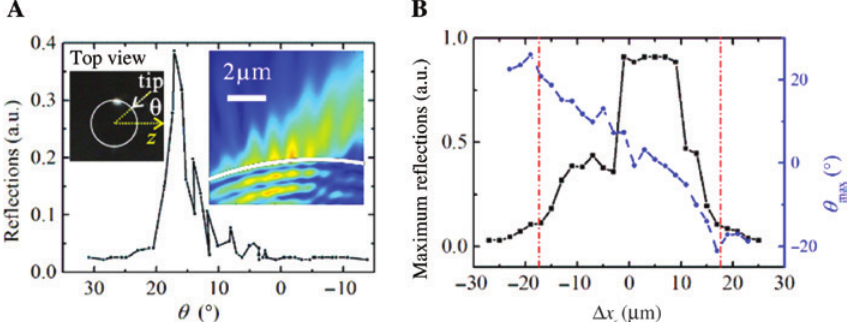
Figure 4: The amplitude of the reflection as a function of the spatial position of the microsphere and the nanotip. (A) Peak value of the reflection varies with the position of the nanotip on the sphere with the microsphere fixed at Δ x top view of the sphere-tip coupling system. The white arrow points out the scattering spot of the nanotip. Right inset: simulated distribution of a Gaussian beam focused by the microsphere. (B) Maximum peak value in the reflection spectrum (black solid curve) and the correspond- ing position of the nanotip (blue dashed curve) vary with the position of the sphere, Δ x dot-dashed lines indicate the boundaries of the microsphere at Δ x